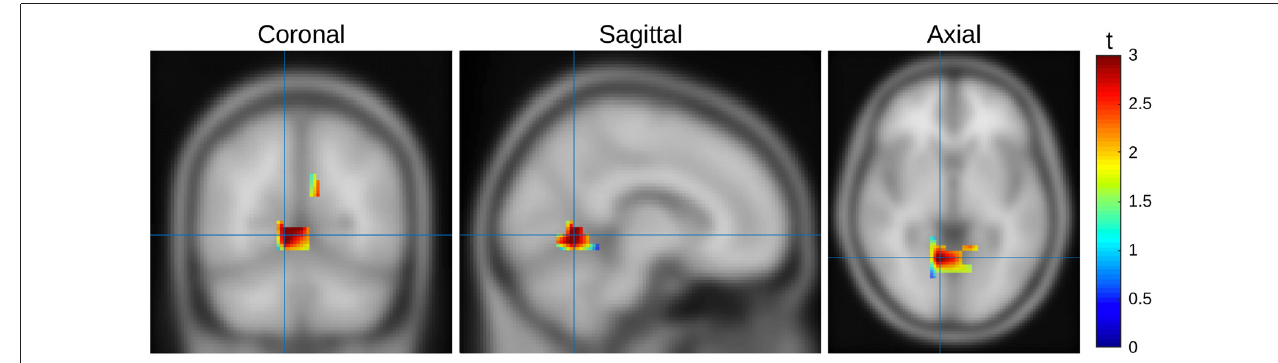
FIGURE 9 | Source mapping results, seen vs. unseen trials of both experiments, first time window. Activity represented as t scores. Orthogonal slices aligned to the highest t -score (MNI [8 − 62 4]).